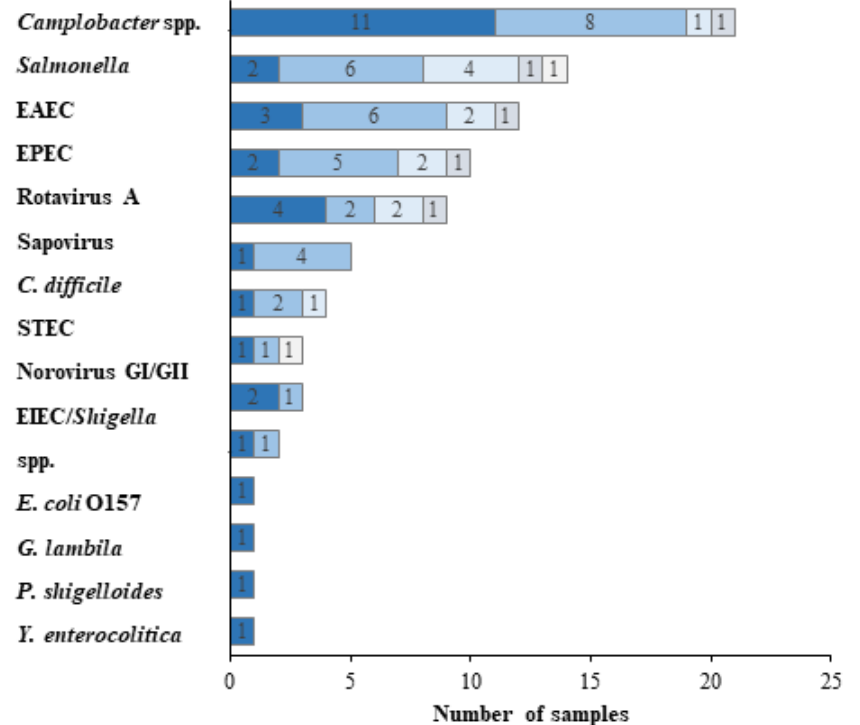
Figure 3. Distribution of causative pathogens in the study group according to age. The various causative agents of GIs distribute differently in distinct age groups, as presented in the graph.